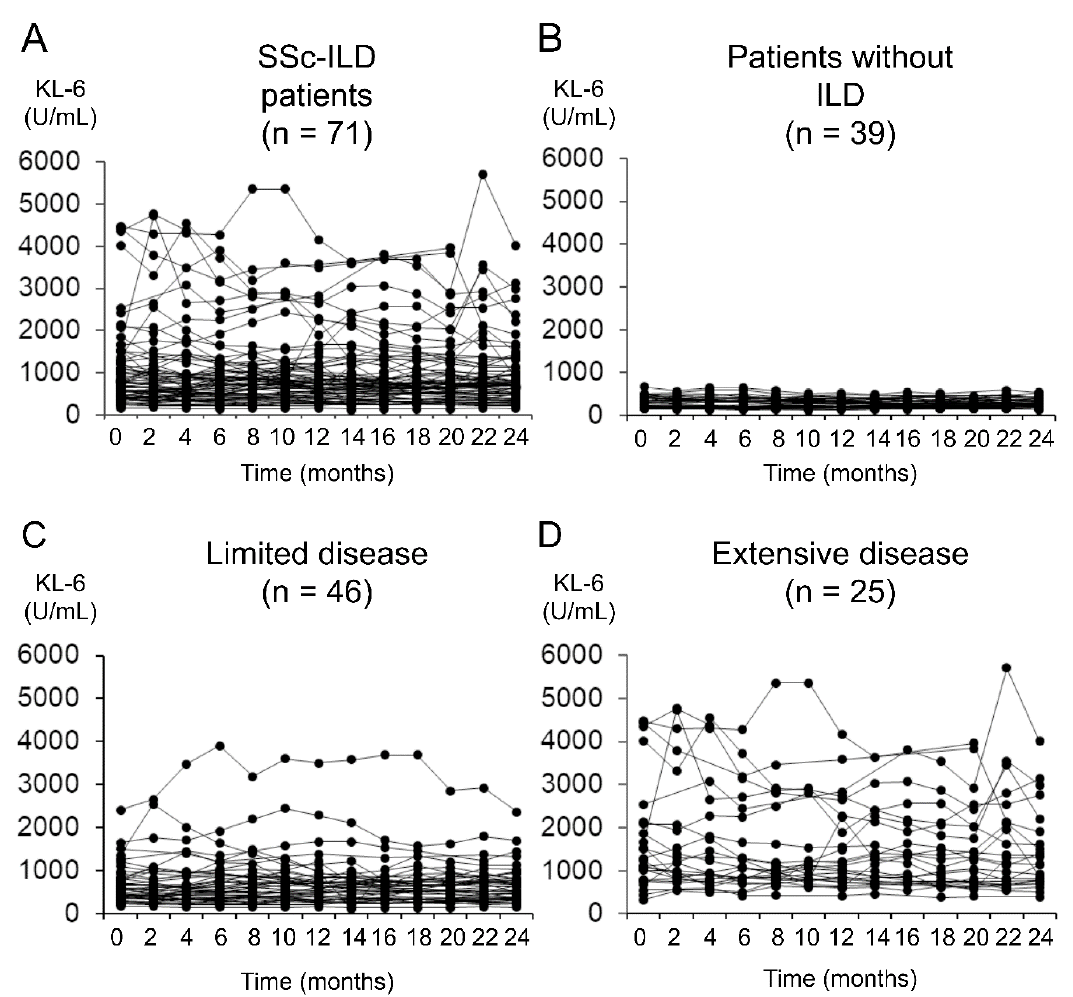
Figure 1. Longitudinal changes in serum KL-6 levels over 2 years after SSc diagnosis. ( A ) SSc patients with ILD; ( B ) SSc patients without ILD; ( C ) SSc patients with ILD and limited disease; and ( D ) SSc patients with ILD and extensive disease.